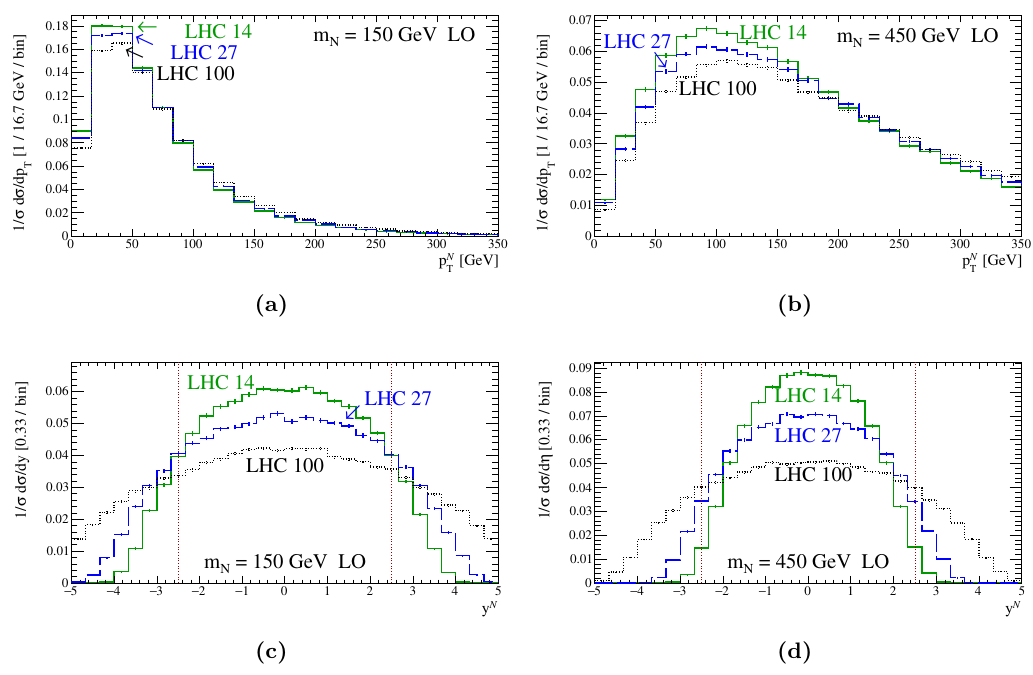
Figure 5. Normalized parton-level (a,b) transverse momentum ( p N distributions for N produced in the LO DY process pp